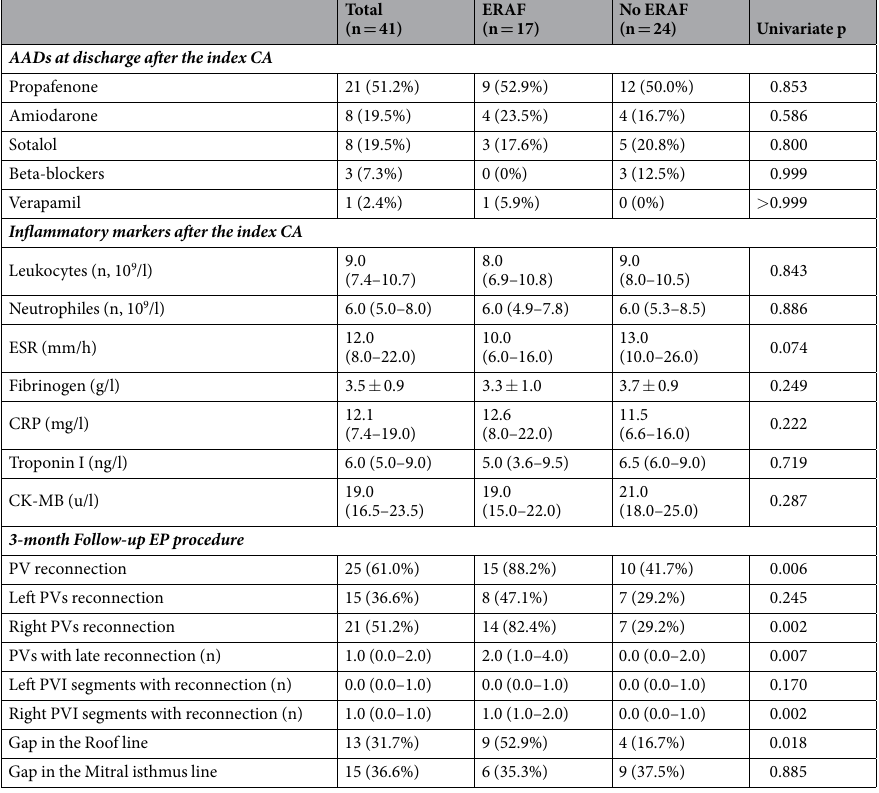
Table 2. Data after the index ablation and from the 3-month electrophysiology procedure. Data are presented as mean ± standard deviation, median (25th to 75th percentile) or numbers (percentages). ERAF, early recurrence of atrial fibrillation; AAD, anti-arrhythmic drug; CA, catheter-ablation; ESR, erythrocyte sedimentation rate; CRP, C-reactive protein; CK-MB, creatin-kinase MB iso-enzyme; EP, electrophysiology; PV, pulmonary vein; PVI, pulmonary vein